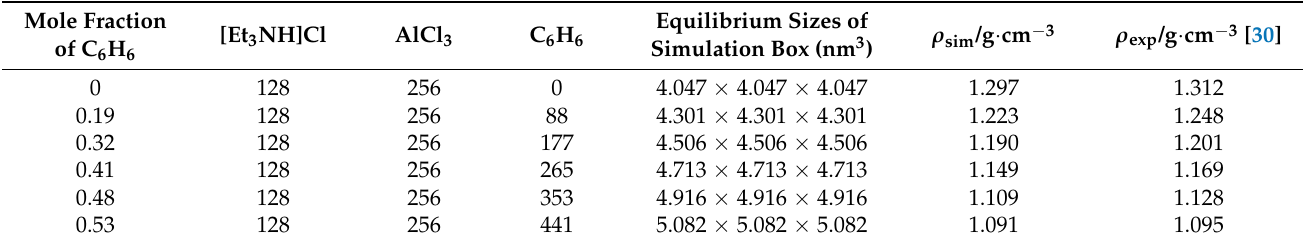
Table 1. Particle numbers, equilibrium box sizes, simulated density and experimental density of [Et 3 NH]Cl/AlCl 3 with different mole fractions of C 6 H